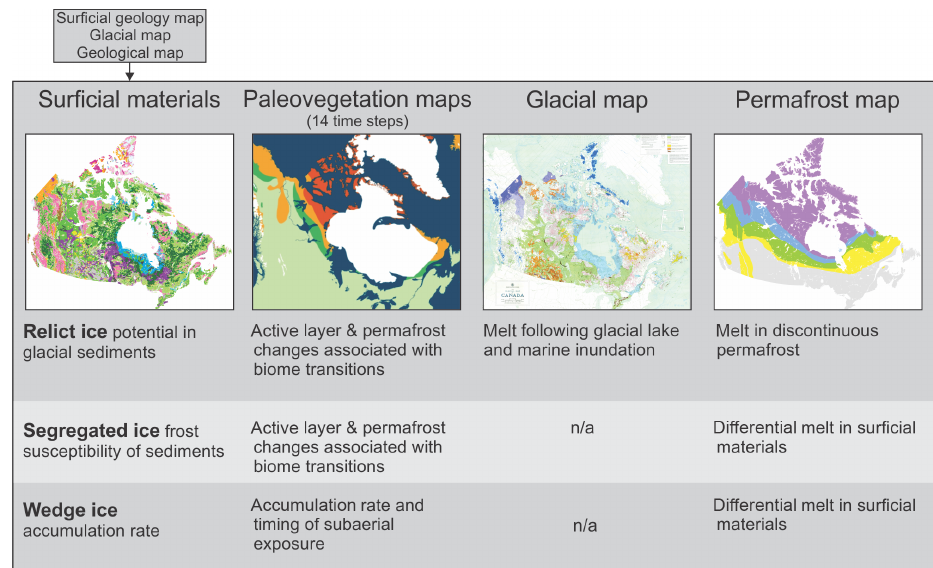
Figure 1. General model framework indicating datasets used and processes represented for the three ground ice types. See text for descriptions of each dataset. Table 1. Examples of surficial material units, soil texture, and resulting assessment of frost susceptibility. Surficial